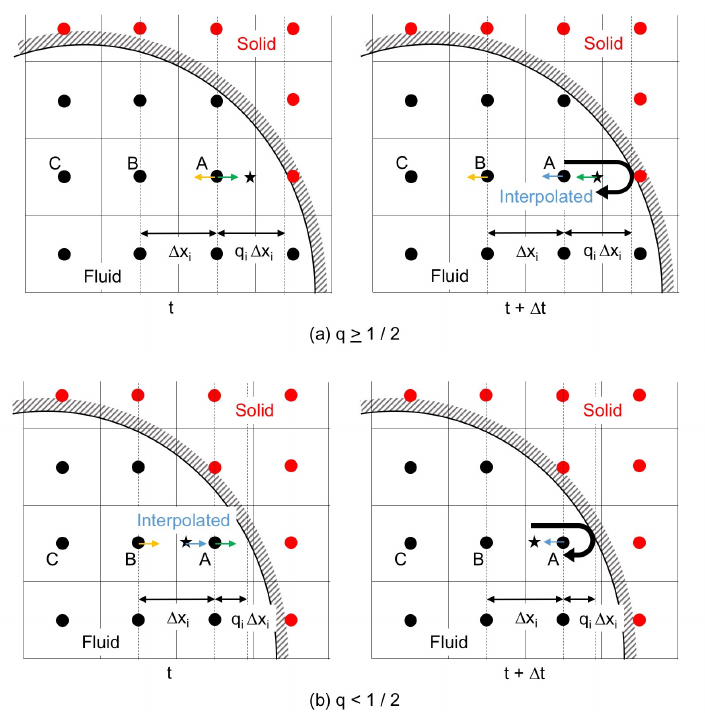
Figure 2. Interpolated bounce-back scheme; ( a ) interpolation after the collision with the solid wall, q ≥ 1/2; and ( b ) interpolation before the collision, q <